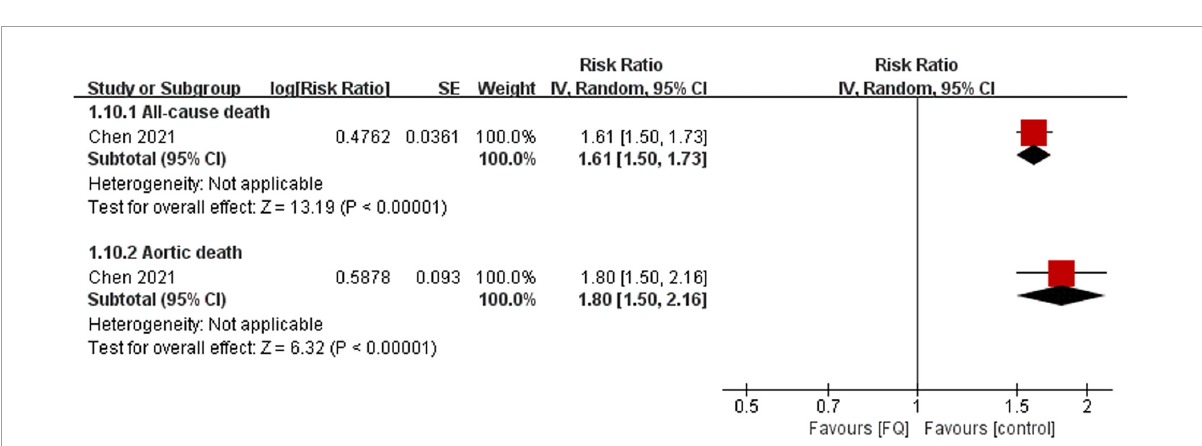
FIGURE4 Forest plot of the risk of aortic aneurysm or dissection (AAD) in the comparison of fluoroquinolones (FQs) vs. controls within a 90-day risk period. FQs, fluoroquinolones; IV, inverse variance; CI, confidence interval.